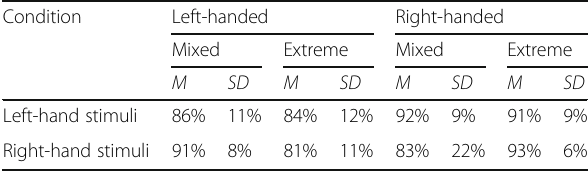
Table 3 Descriptive statistics for accuracy of same-hand/same-